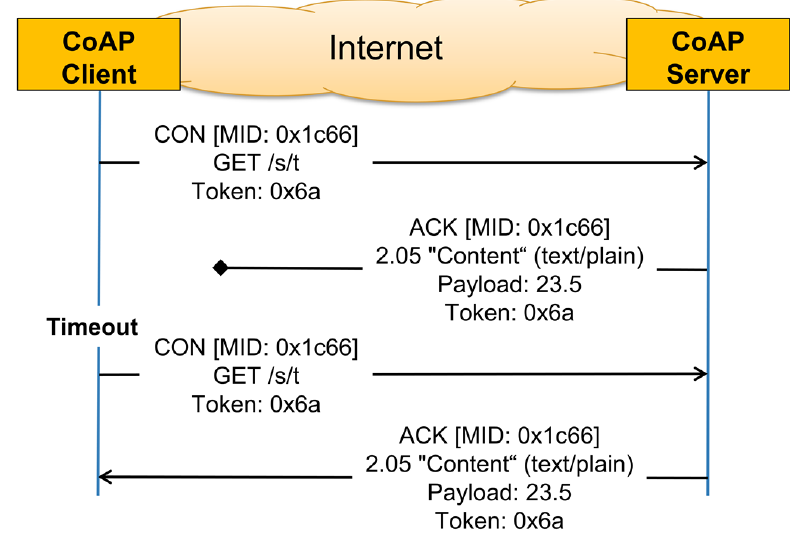
Figure 2. Example of CoAP Confirmable Message (CON) exchange. If the client does not receive an ACK for its CON within a certain time, it retransmits the same CON again until it gets acknowledged or until the client runs out of retransmission